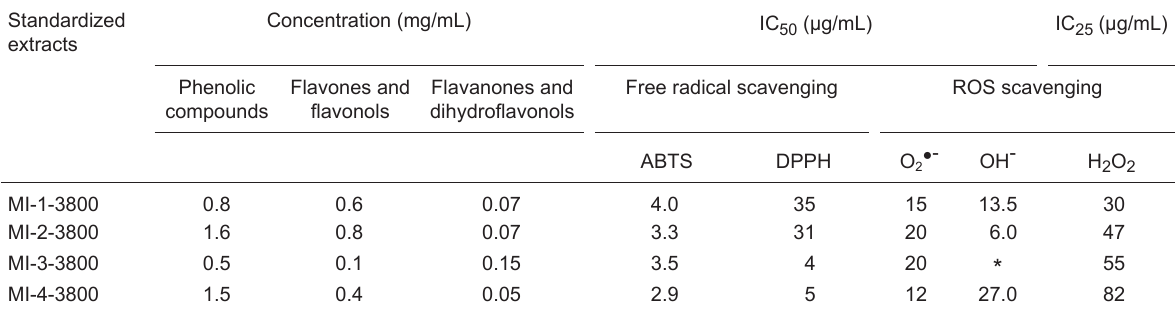
Table 1. Phenolic compound/flavonoid content and antioxidant activity of plant species extracts from the Argentine Puna (8). Standardized